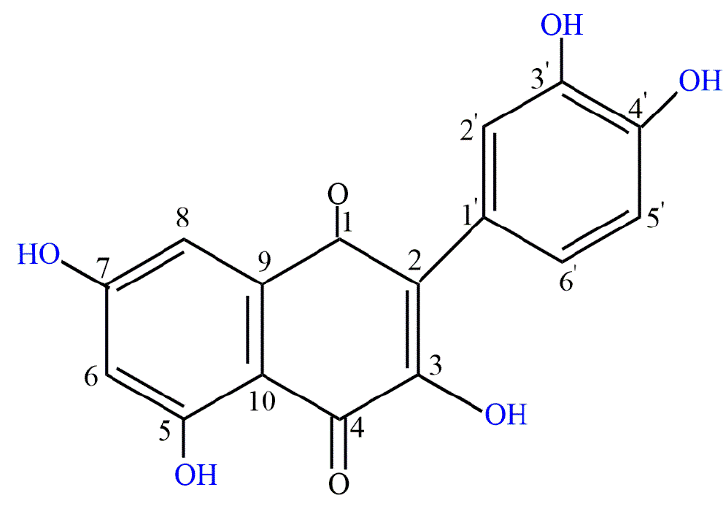
Figure 1. Chemical structure of quercetin.